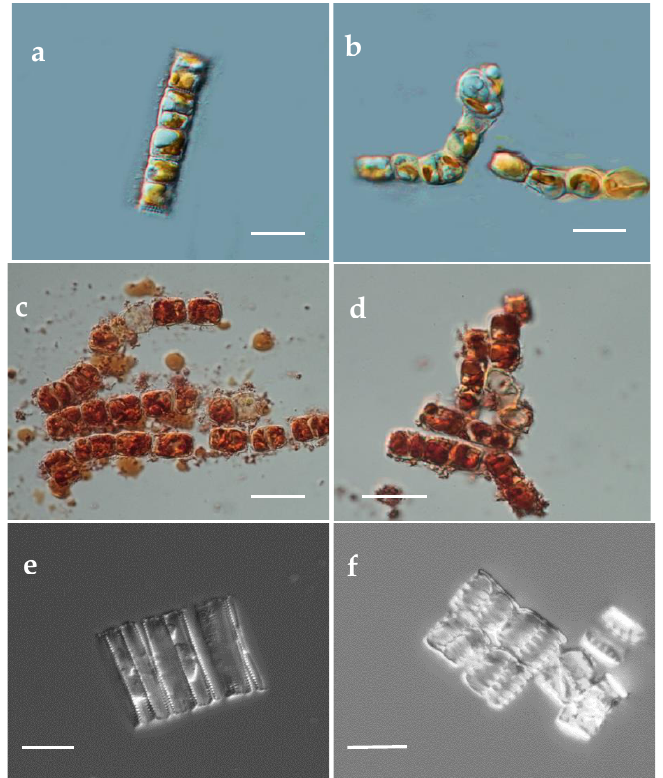
Figure 2. Light microscopic images of control ( a , b ), Ag treated ( c , d ) and cleaned frustules ( e , f ) of G. flavovirens and G. mutabilis respectively [Scale bar 5 µm].